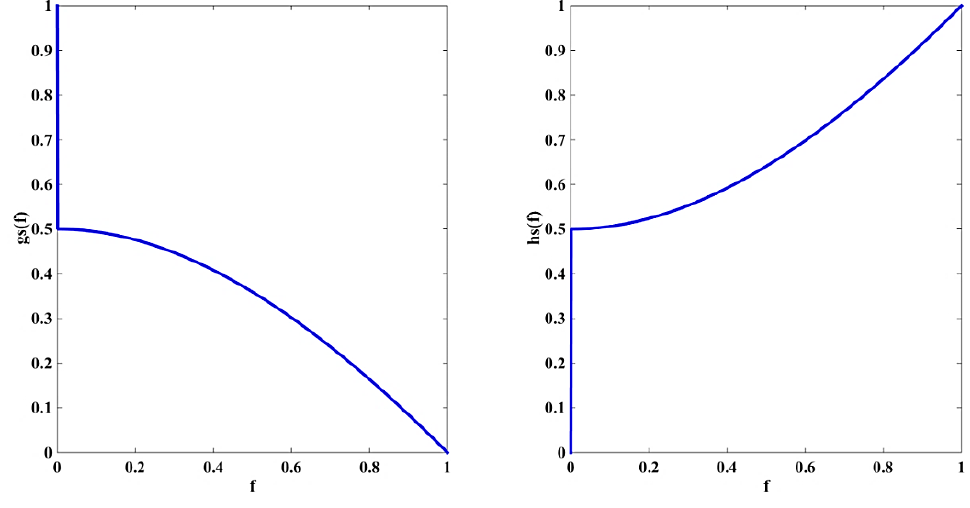
Figure 1. Variation of coefficients when (cid:2028) = 1.